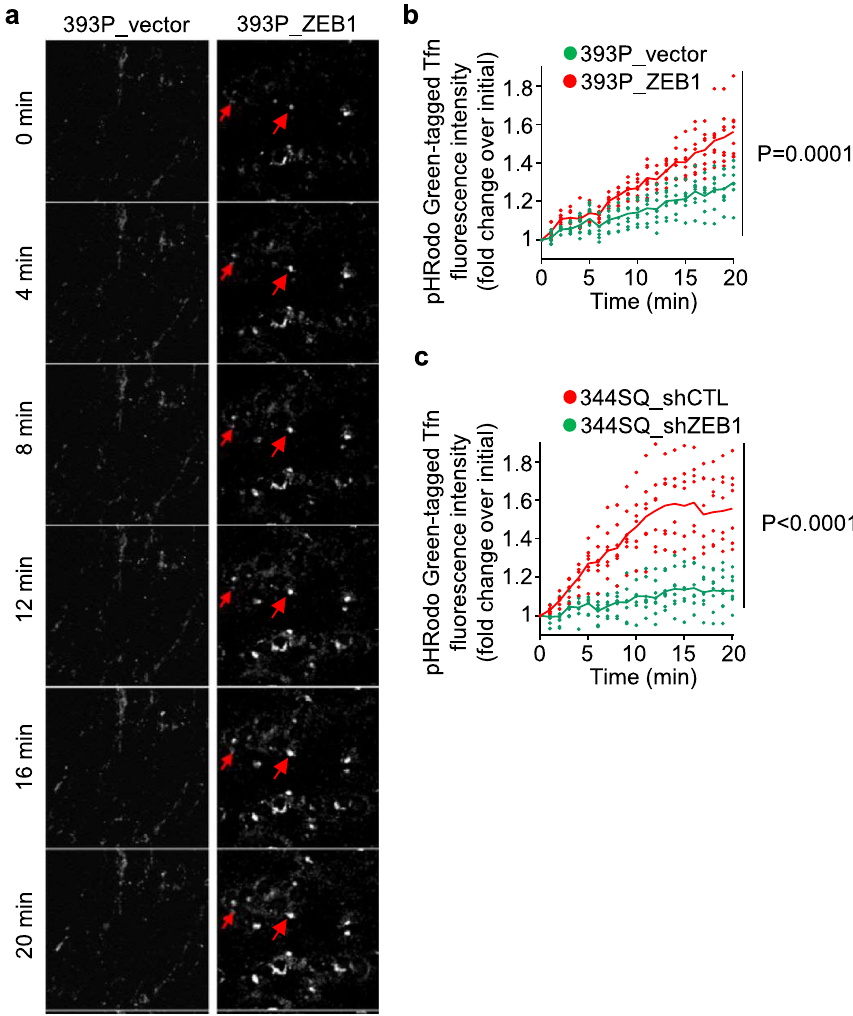
Fig. 4 ZEB1 accelerates endosomal acidi fi cation. a Montage of live-cell confocal microscopic images of 393P cells that have ectopic expression of ZEB1 or empty vector and were treated with pHRodo Green-tagged Tfn. Gains in signal intensity over time (red arrows) mark vesicles that have reduced intravesicular pH and enhanced maturation. Scale bars, 10 µ m. b , c Quanti fi cation of pHRodo Green-tagged Tfn signal intensities following ZEB1 gain-of- function ( b ) or ZEB1 loss-of-function ( c ). Signal intensities in each cell (dot) determined at each time point after pHRodo Green-tagged Tfn treatment initiation. n = 8 cells from 4 independent experiments. P values, two-way